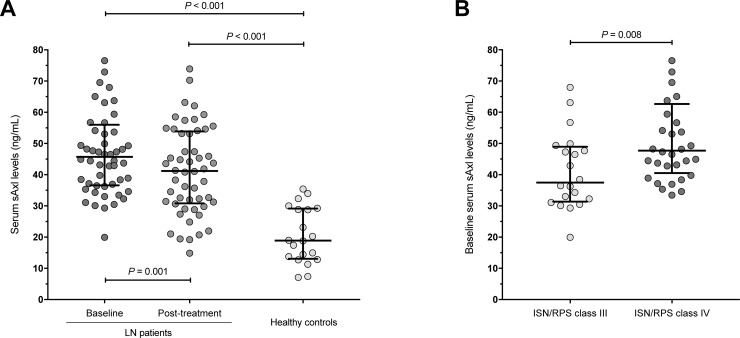
sAxl levels in LN patients and healthy subjects.The scatterplots in panel A delineate serum levels of soluble (s)Axl receptor in patients with lupus nephritis (LN) before and after induction treatment (n = 52), and in healthy controls (n = 20). Baseline serum levels of sAxl in LN patients were significantly elevated (median; IQR: 45.7; 36.6–56.0 ng/mL) compared with the healthy controls (P<0.001; Mann-Whitney U test). Following treatment, serum levels of sAxl showed a significant decrease (P = 0.001; Wilcoxon signed-rank test), but remained significantly higher compared to serum sAxl levels in healthy controls (P<0.001; Mann-Whitney U test). In panel B, the scatterplots delineate serum levels of sAxl across nephritis classes. Baseline serum levels of sAxl were higher in patients with ISN/RPS class IV LN compared to patients with ISN/RPS class III nephritis (P-value derived from Mann-Whitney U test). Lines and whiskers denote medians and the 25th and 75th percentiles. Outliers may have been omitted due to scaling.